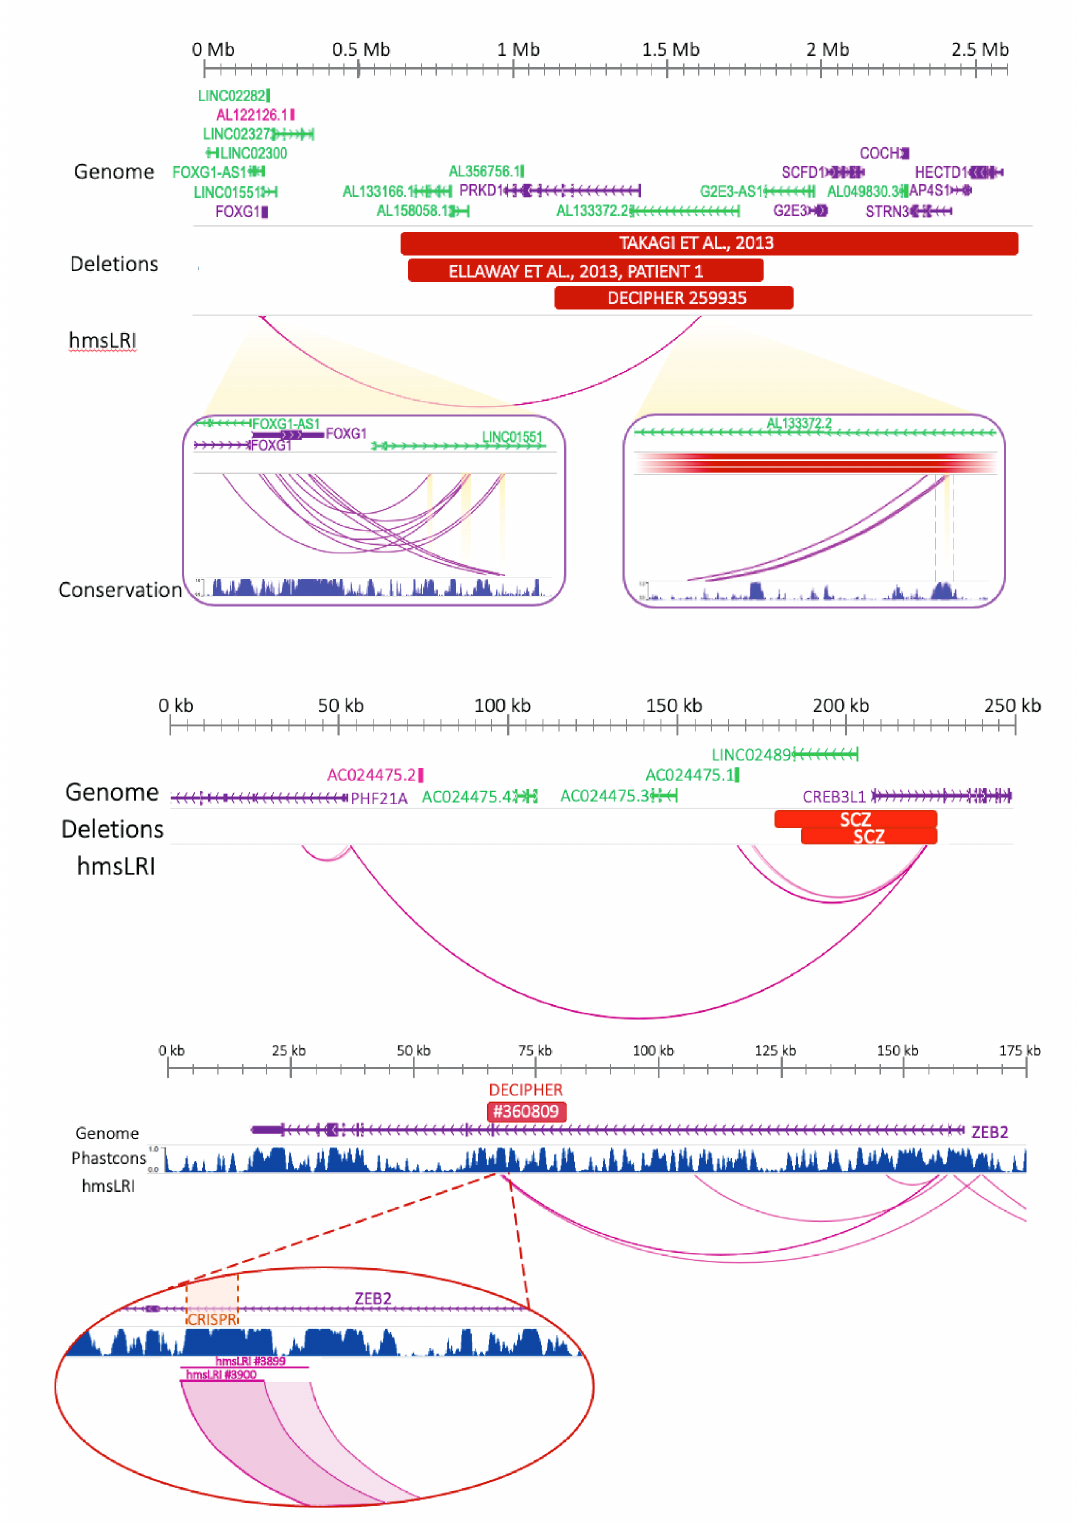
Figure 6. CNV involving hmsLRI-E, but not the interacting gene promoter, suggest that deregulation of the (intact) connected gene may be involved in pathogenesis. ( A ) CNV (microdeletions) identified in NDD patients involve an hmsLRI-E connected to the FOXG1 promoter. The deletions track represents CNVs harbored by neurodevelopmental delay and Rett-like syndrome patients